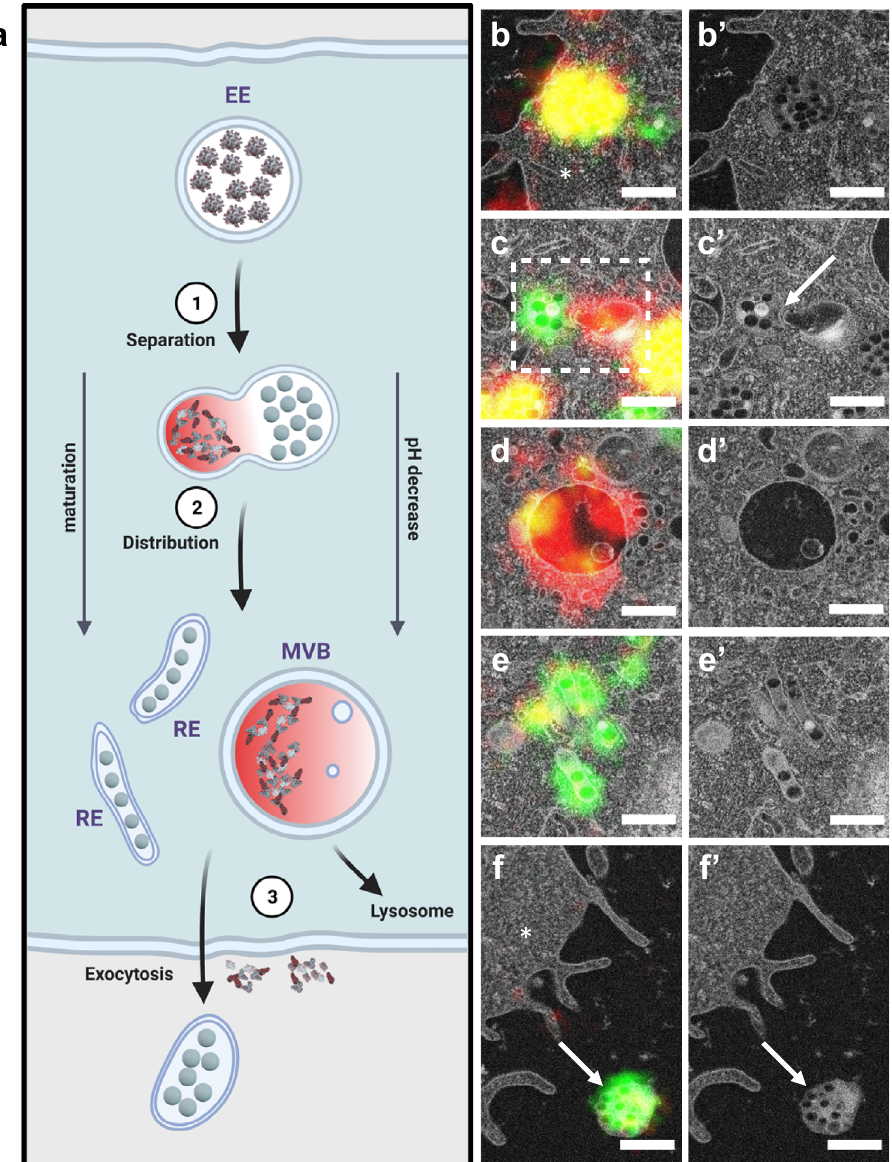
Fig. 5 | Intracellular fate of the protein corona and PS NPs illustrated by CLEM and EM micrographs. a Scheme of intracellular separation of the protein corona and PS NPs and exocytosis of NPs. Scheme was created with Biorender.com. b , b ′ Protein corona-coated PS NPs in an endosome after internalization. Intracellular space is indicated with a starsymbol. c , c ′ Separation of the protein corona and PS NPs. Separation event is highlighted with a dotted square and an arrow. d , d ′